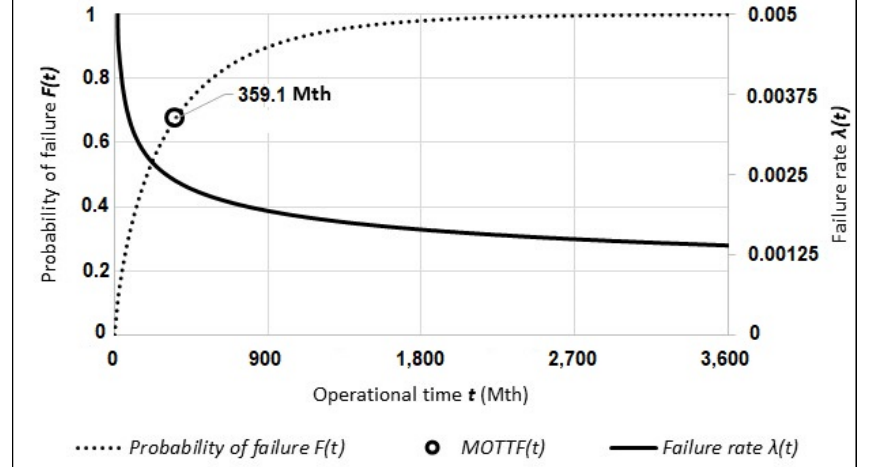
Figure 3. Failure rate λ (t) for the forwarder f810D-136.